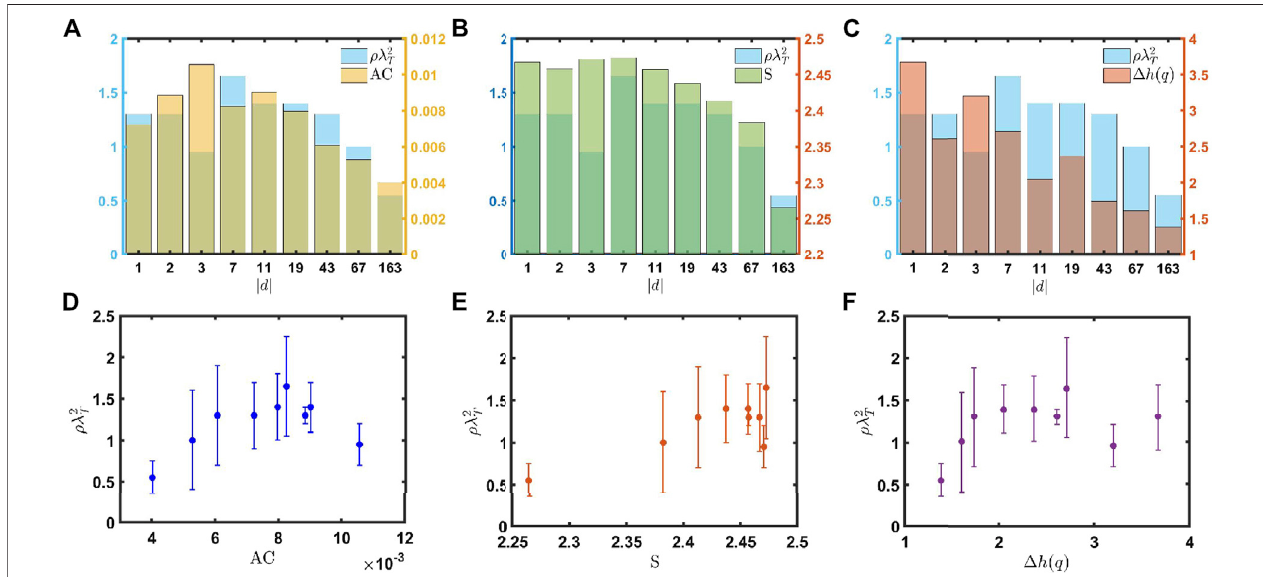
FIGURE 10 | Histograms of the estimated values of the DLT-threshold ( ρλ 2 T ) of all the investigated arrays together with their algebraic connectivity AC in panel (A) , nodal entropy S in panel (B) , and multifractal width Δ h ( q ) in panel (C) . Panels (a – c) compare ρλ 2 T with respect to AC , S , and Δ h ( q ), respectively.